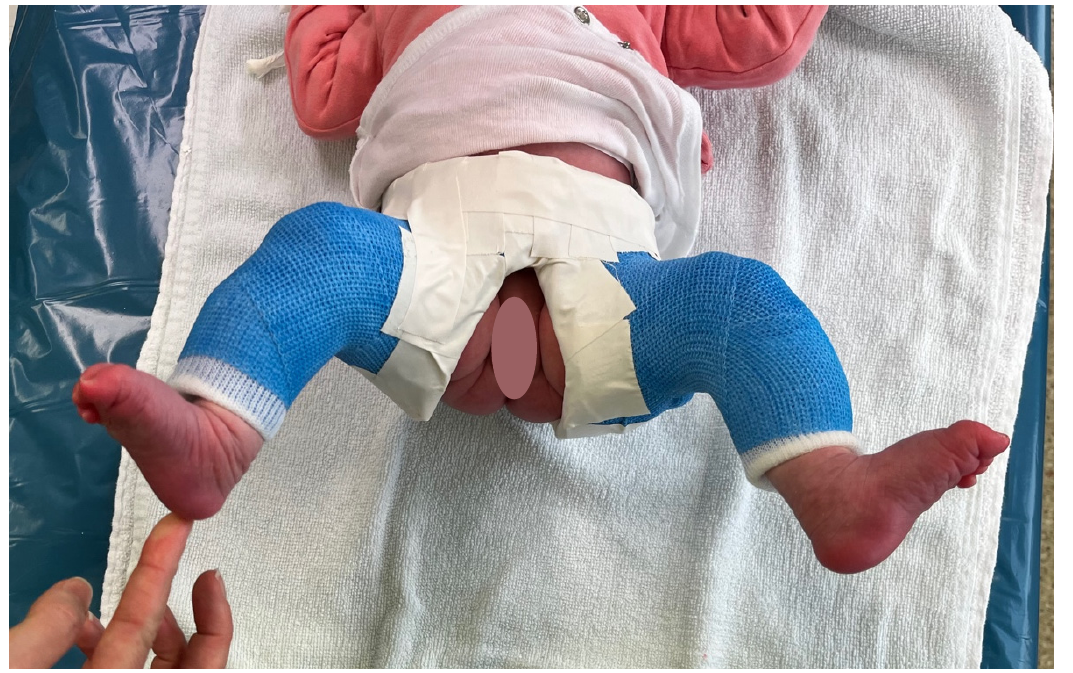
Figure 1. Shows the therapy algorithm of our treatment.